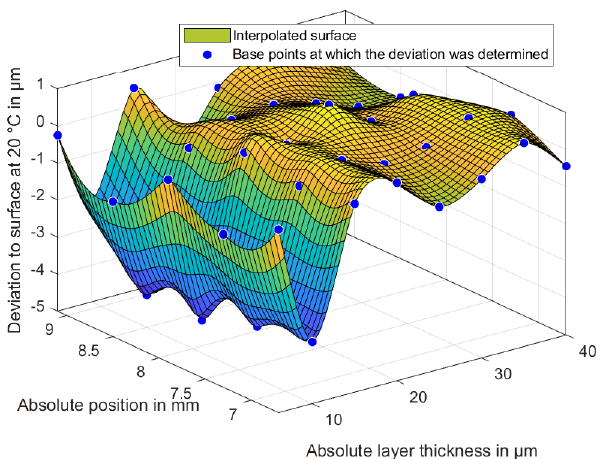
Figure 16. Standard deviation at 25 ◦ C and a test repetition of n =